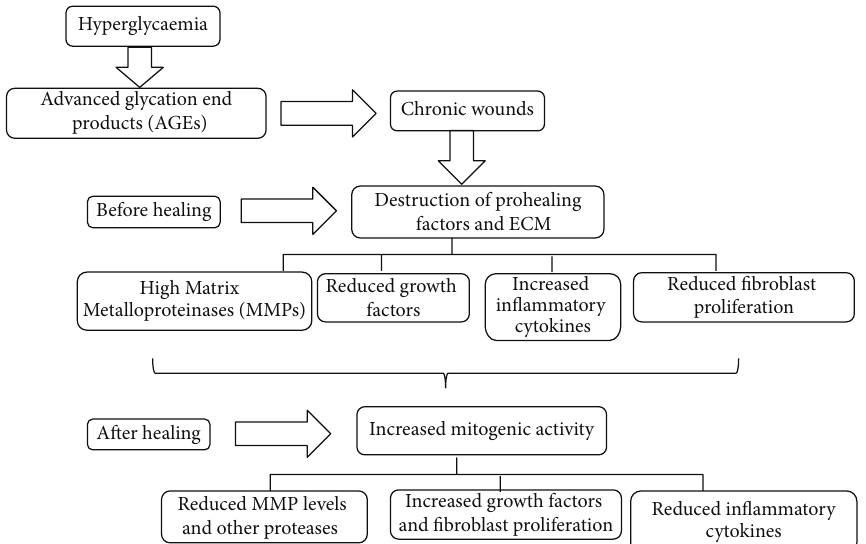
Figure 1: Mechanism of MMPs in chronic wounds. The development of chronic wounds results from delayed inflammation producing high levels of proteinases that destroy the essential elements of wound healing, growth factors, various receptors, and ECM proteins leading to increased MMPs, inflammatory cytokines, and reduced growth factors. The destruction of prohealing factors and ECM also reduces the ability for cells to migrate and proliferate. However as the wound begins to heal through various therapies, there would be increased mitogenic activity, reduced protease activity, and reduction of inflammatory